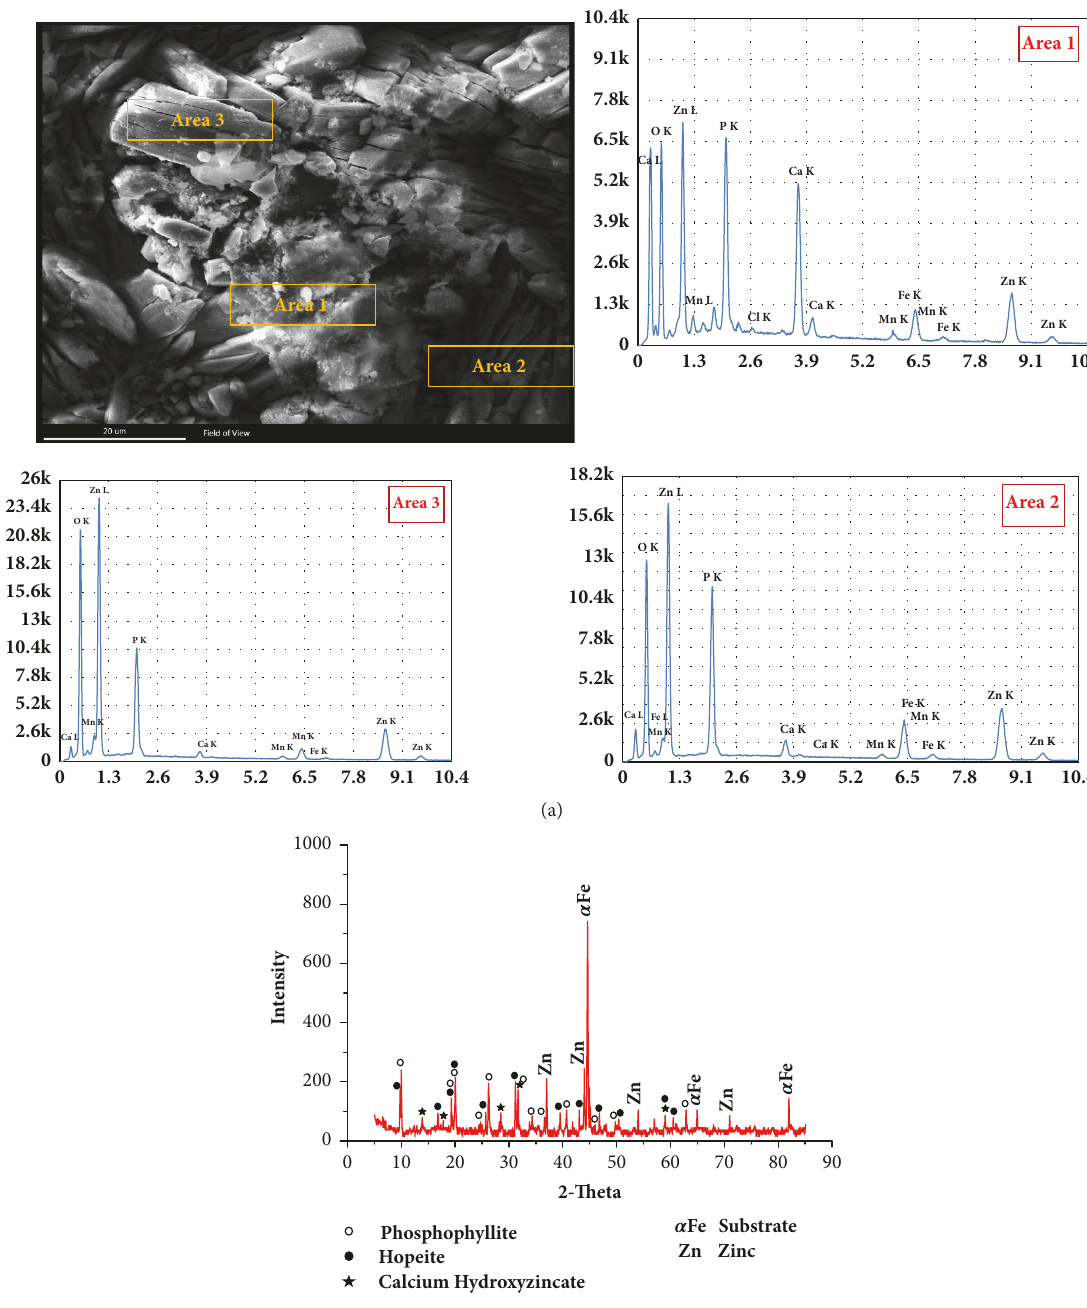
Figure 20: SEMs and EDX (a) and XRD analysis (b) of ZnP-Mn coating after immersion in (CH-Cl) solution for 96